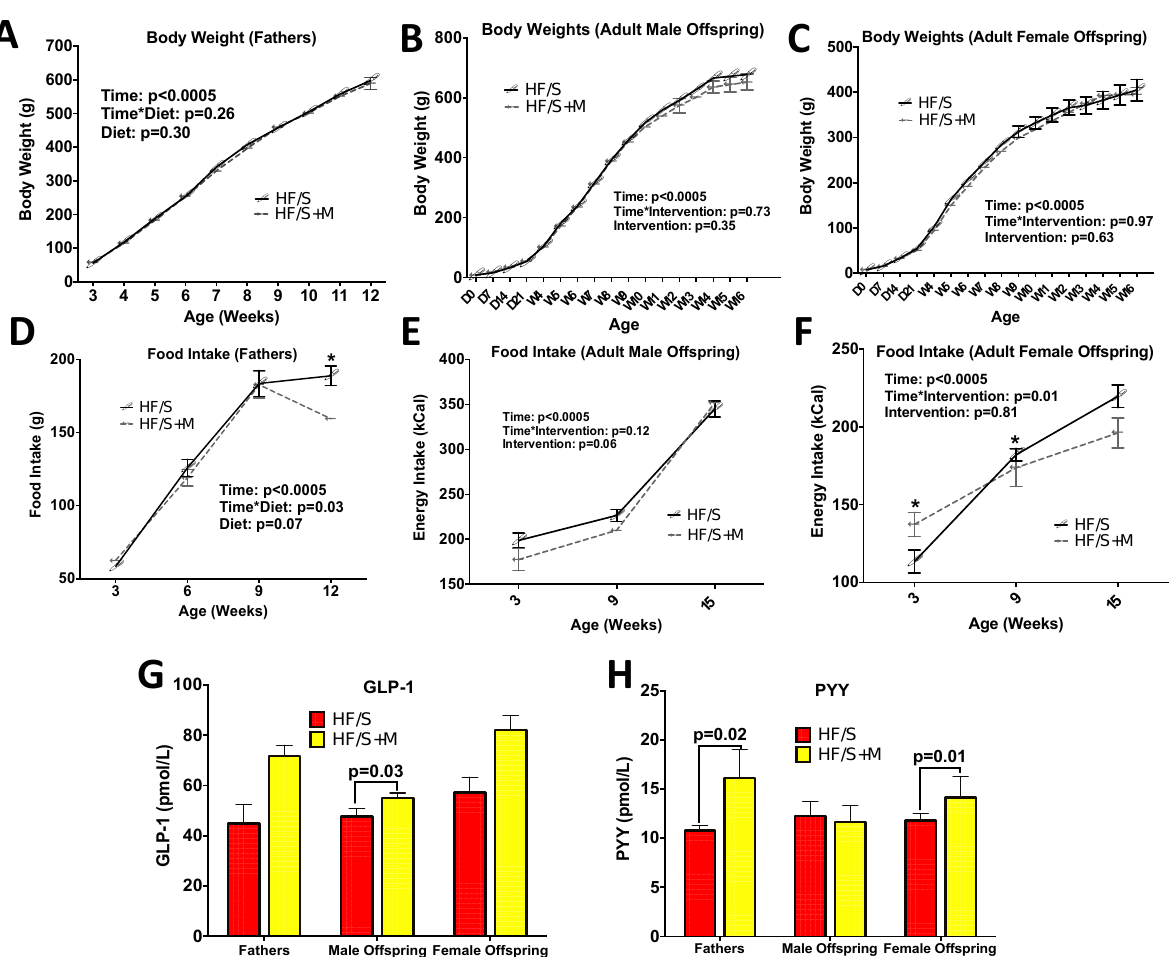
Figure 1. Body Weight, Food Intake and Gastrointestinal Peptides. The body weight of ( A ) fathers, ( B ) adult male offspring and ( C ) adult female offspring. The food intake of ( D ) fathers, ( E ) male offspring ( F ) female offspring; ( G ) serum glucagon- like peptide-1 (GLP-1) and ( H ) peptide tyrosine tyrosine (PYY) . The values are means ± SEM, n = 8–13. In adult offspring, there was a significant sex effect in the overall model for bodyweight ( p = 0.0001), food intake ( p = 0.0001), GLP-1 ( p = 0.002); therefore, subsequent analysis was performed in males and females separately. * represents a significant difference between groups, p < 0.05. Table 2. Reproductive markers for paternal Table 1. The body composition of fathers at mating at 12 weeks of age and offspring at 16 weeks of age. HF/S HF/S+M p -Value